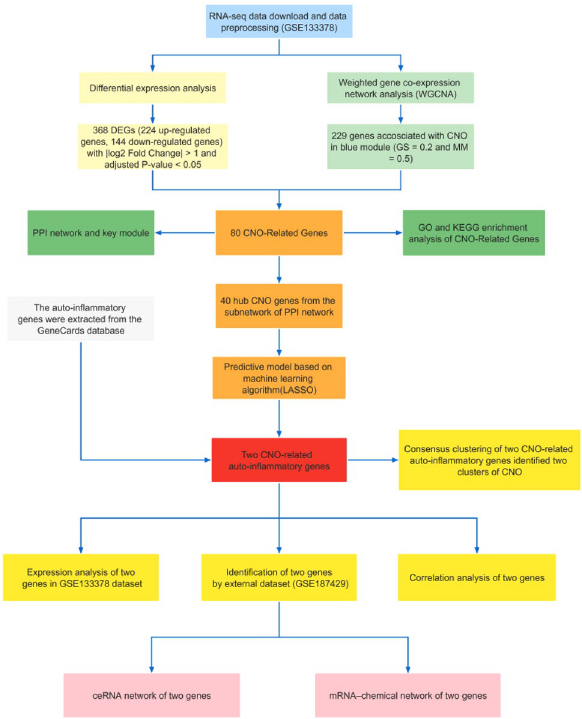
Figure 1. Flowchart of data analysis in this study. This included RNA-seq data download, differential expression analysis, and WGCNA analysis. Followed by the construction of PPI network and enrichment analysis, building machine learning models, screening of CNO-related auto-inflammatory genes in conjunction with the GeneCards database and construction of the ceRNA network, and finally validation with external